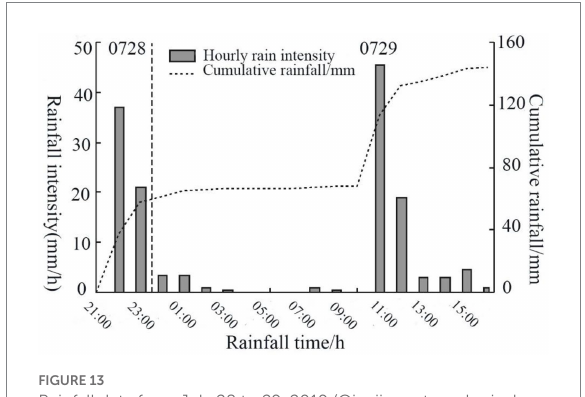
FIGURE 13 Rainfall data from July 28 to 29, 2019 (Qianjin meteorological station).